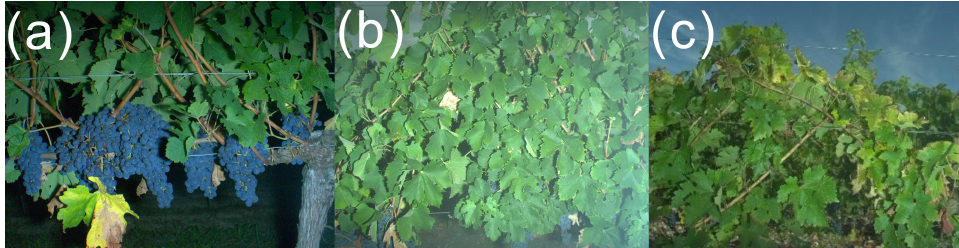
Figure 5. Examples of framing differences on grapevine acquisitions. ( a ) Bottom part and trunk of the vine. ( b ) Leaf area of the vine. ( c ) Top part of the vine. Images extracted from the 4 projects’ datasets.